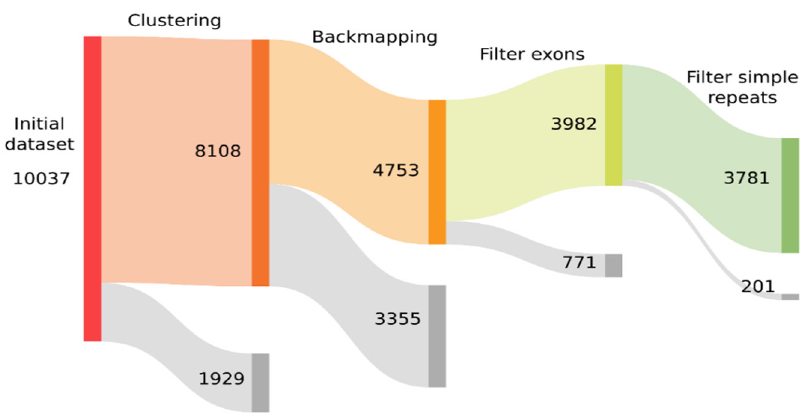
Figure 3. Sankey plot showing the process of filtering of the initial consensus sequences built by RepeatModeler. In each step, in grey is shown how many models were discarded due to the filtering process and in color, how many remained for the next step.